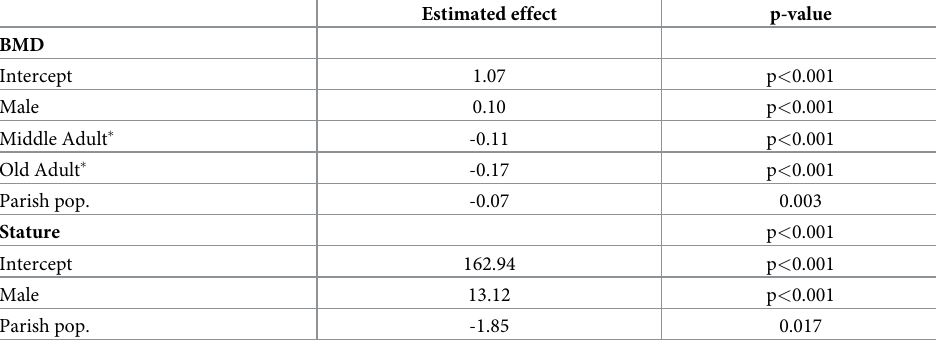
Table 3. Results of the linear regression model for BMD and stature. Estimated effect with females as reference level.